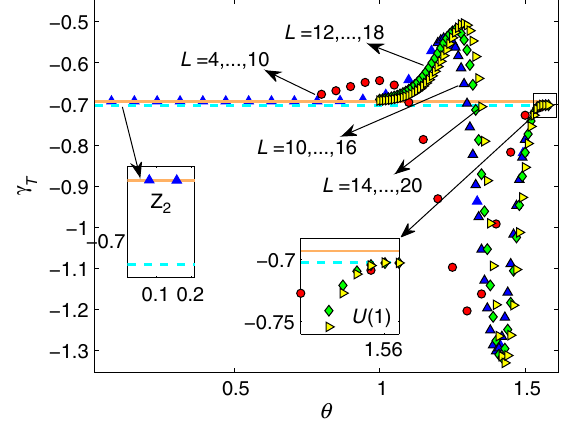
FIG. 24. The topological entropy γ defined in Eq. (49) and T extracted from the scaling of the entropy of half infinite cylinders with respect to their circumference L . The red dots are obtained by considering the scaling of the entropy in the interval L ¼ 4 ; … ; 10 , blue up-facing triangles L ¼ 10 ; … ; 16 , green squares L ¼ 12 ; … ; 18 , and the yellow triangles pointing to the right L ¼ 14 ; … ; 20 . The solid orange line represents the exact value of γ for the Z 2 spin liquid in Eq. (50), while the cyan dashed line T represents its value for the U ð 1 Þ spin liquid from Eq. (52) with R associated with Δ ¼ − 1 = 2 . We see that for small θ , γ coincides, T independently of the size of the cylinder considered, with the expected exact value Z 2 (left inset). As we move toward the transition, γ shows a transient oscillation that tends to become T sharper and deeper and move toward π = 2 for larger L . At π = 2 , it attains again the expected analytical value with very small correc- tions induced by considering the two different set of data (right inset). In the main text, we provide a discussion of these results.